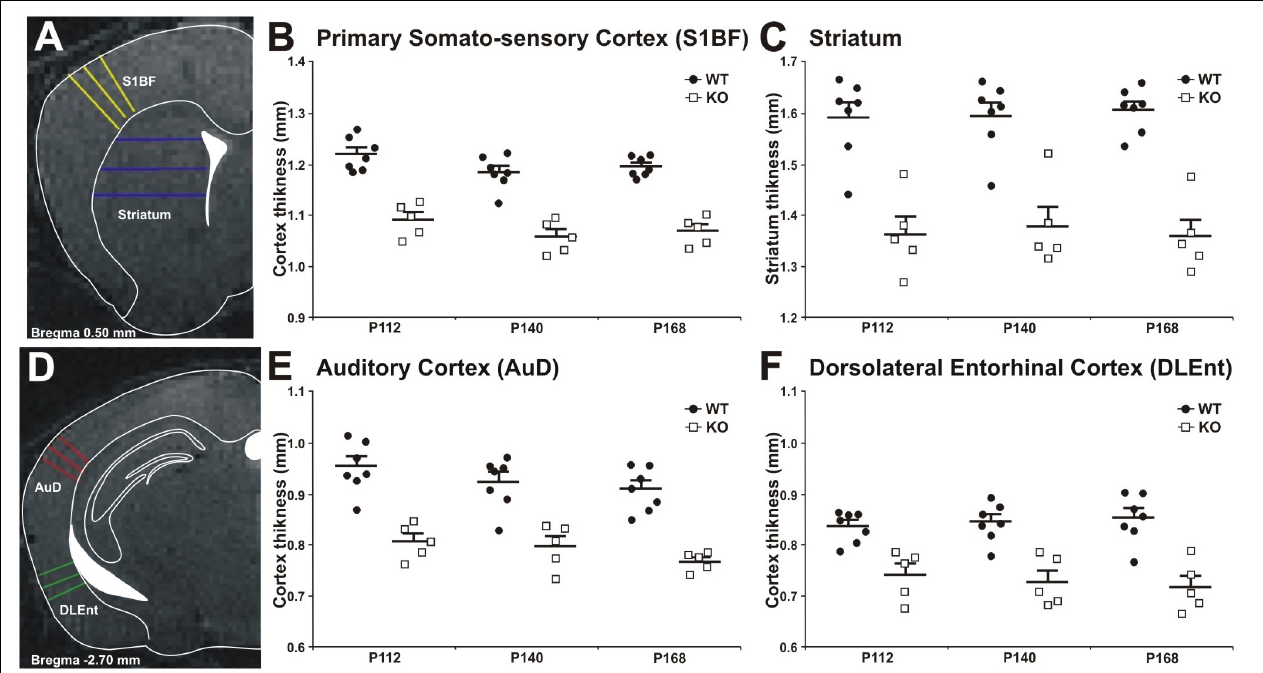
FIGURE 8 | Cortical thickness measurement in WT and MIM KO mice. (A,D) Panels show representative T2-weighted MR images of the areas analyzed, with the approximated corresponding brain levels from the stereotaxic atlas of the mouse brain superimposed (Franklin and Paxinos, 3rd edition 2007). (A) Primary somatosensory cortex barrel field and striatum as measured at Bregma +0.50 mm. (B,C) Primary somatosensory cortex and striatum areas in MIM KO transgenic mice ( n = 5) showed a significant reduction in thickness compared to WT mice ( n = 7). (D) Dorsal area of the auditory cortex and dorsolateral entorhinal cortex as measured at Bregma –2.70 mm. An equal number of lines were manually traced on each area using a “straight line” tool in ImageJ on MRI images acquired at post-natal days P112, P140, and P168. The thickness of different areas in each brain was estimated by three measurements (at different brain levels) in triplicates (see Methods for details). Coronal levels in MRI images were matched to the corresponding plates in mouse atlas (Franklin and Paxinos, 3rd edition 2007), to define the single functional areas. (E,F) Auditory cortex and dorsolateral entorhinal cortex in MIM KO transgenic mice ( n = 5) showed a significant reduction in thickness compared to WT mice ( n = 7). Data are presented as mean + SEM. ∗ denotes statistical significance: ∗ p < 0.05, ∗∗ p <